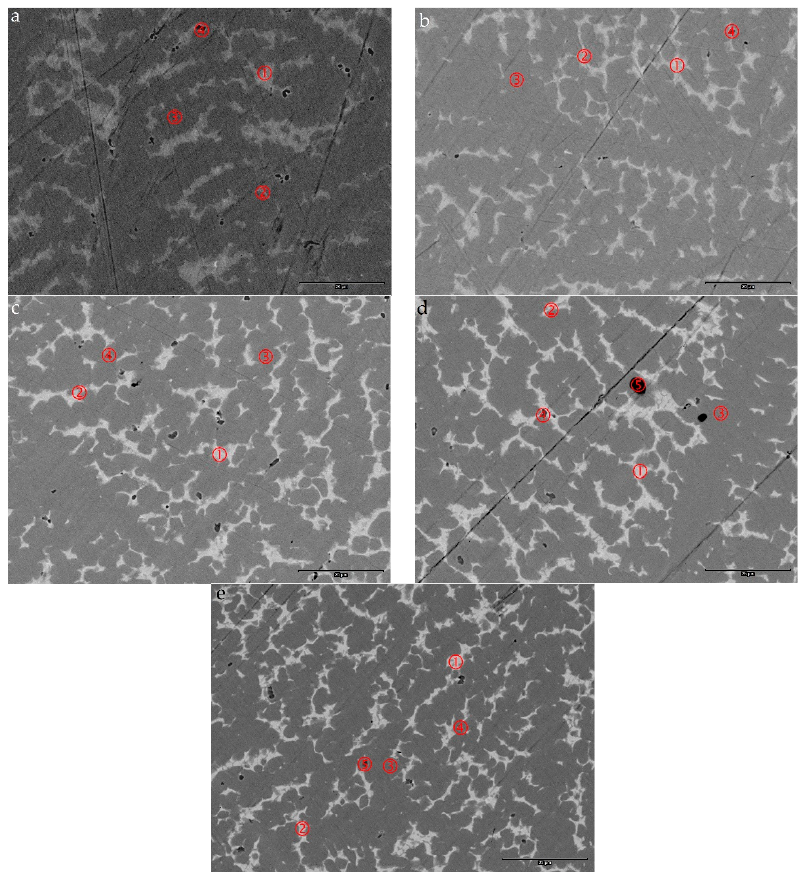
Figure 4. Scanning Electron Microscope Backscattering Electron Images (SEM BEI) micrographs from alloys ( a ) Pd1, ( b ) Pd2, ( c ) Pd3, ( 4 ) Pd4, and ( e ) Pd5. The composition of the numbered areas was analyzed by EDS, and the results are shown in Table 5. The bar at the lower right corner in each